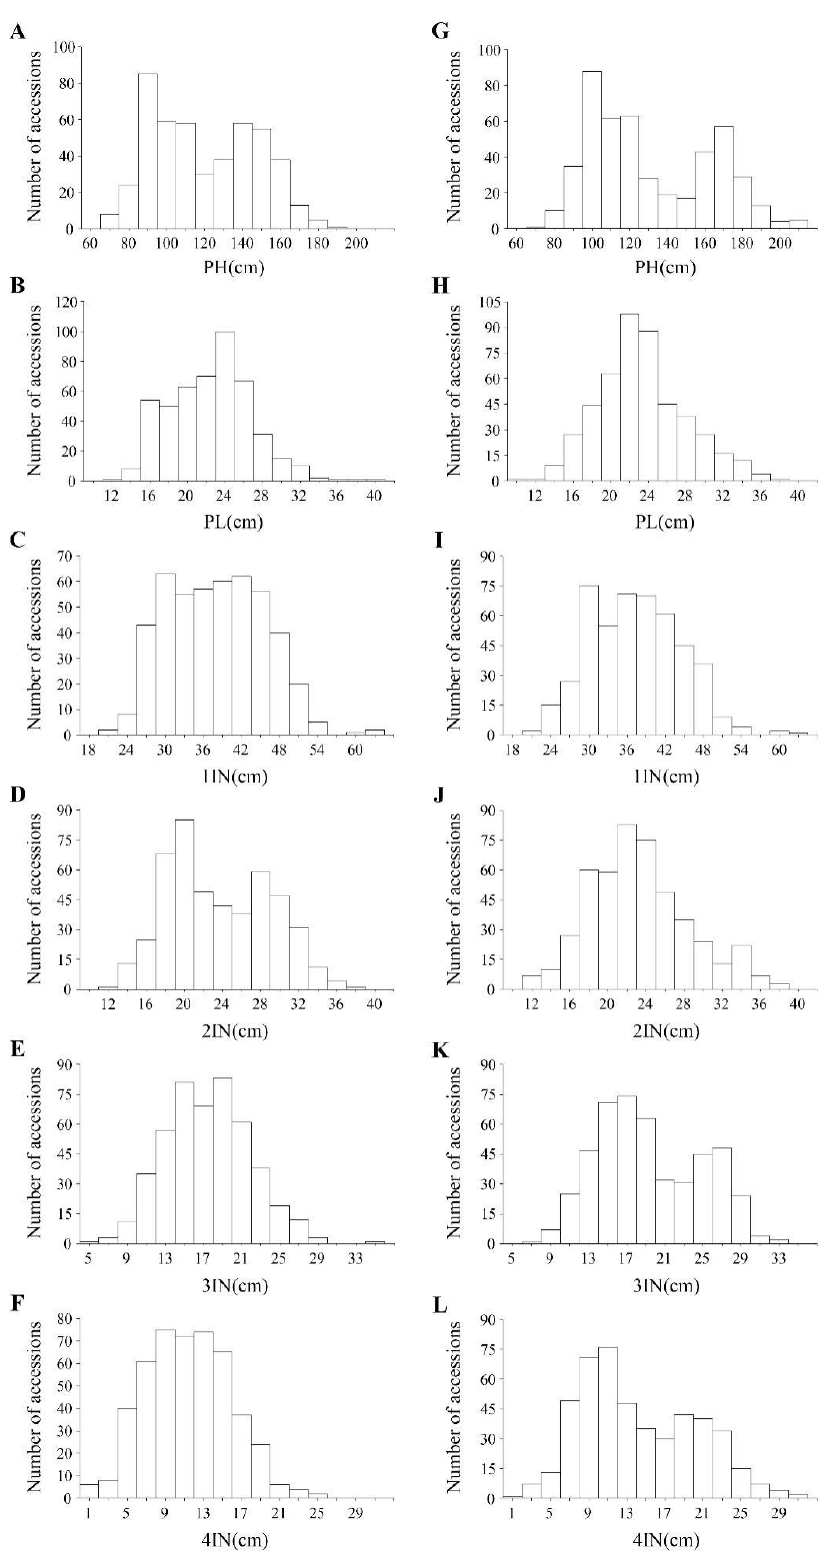
Figure 1. Frequency distribution of plant height and its component traits in the natural population in 2018 ( A – F ) and in 2019 ( G – L ). PH, plant height; PL, panicle length; 1IN, first internode from the top; 2IN, second internode from the top; 3IN, third internode from the top; and 4IN, fourth internode from the